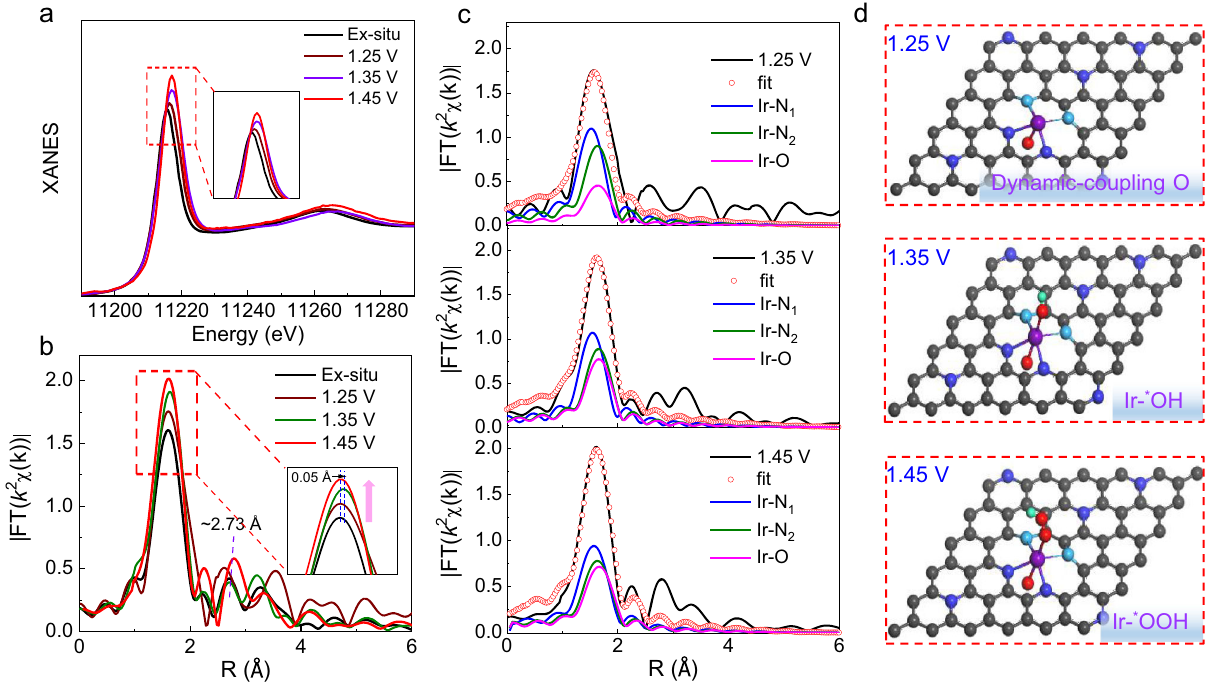
Fig. 5 In situ XAFS measurement. a In situ XANES spectra was recorded at the Ir L 3 -edge of AD – HN – Ir electrocatalyst at different applied potentials from 1.25 to 1.45 V during the OER process. b Corresponding k 2 -weighted Fourier transform (FT) spectra. c The fi tting curves recorded at the Ir L 3 -edge and d OER mechanism diagrams of AD – HN – Ir electrocatalyst at 1.25, 1.35, and 1.45 V. C, black; N 1 , royal blue; N 2 , indigo; O, red; H, green; Ir,